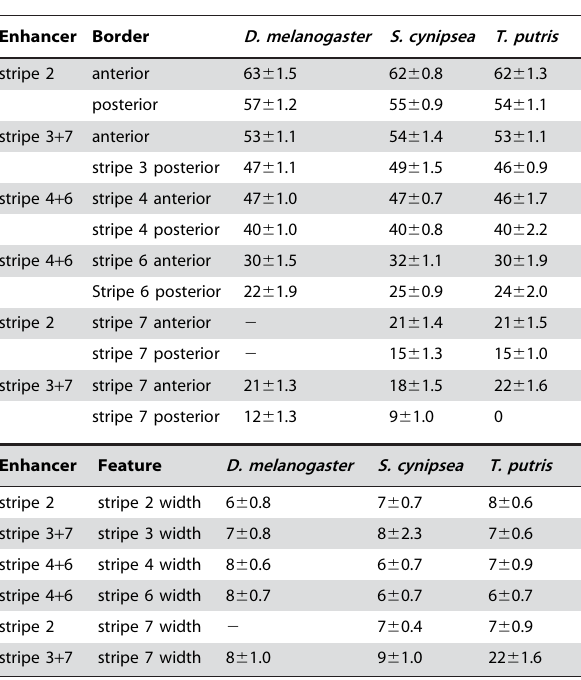
Table 2. Positions of borders and width of eve stripes driven by Drosophila and sepsid